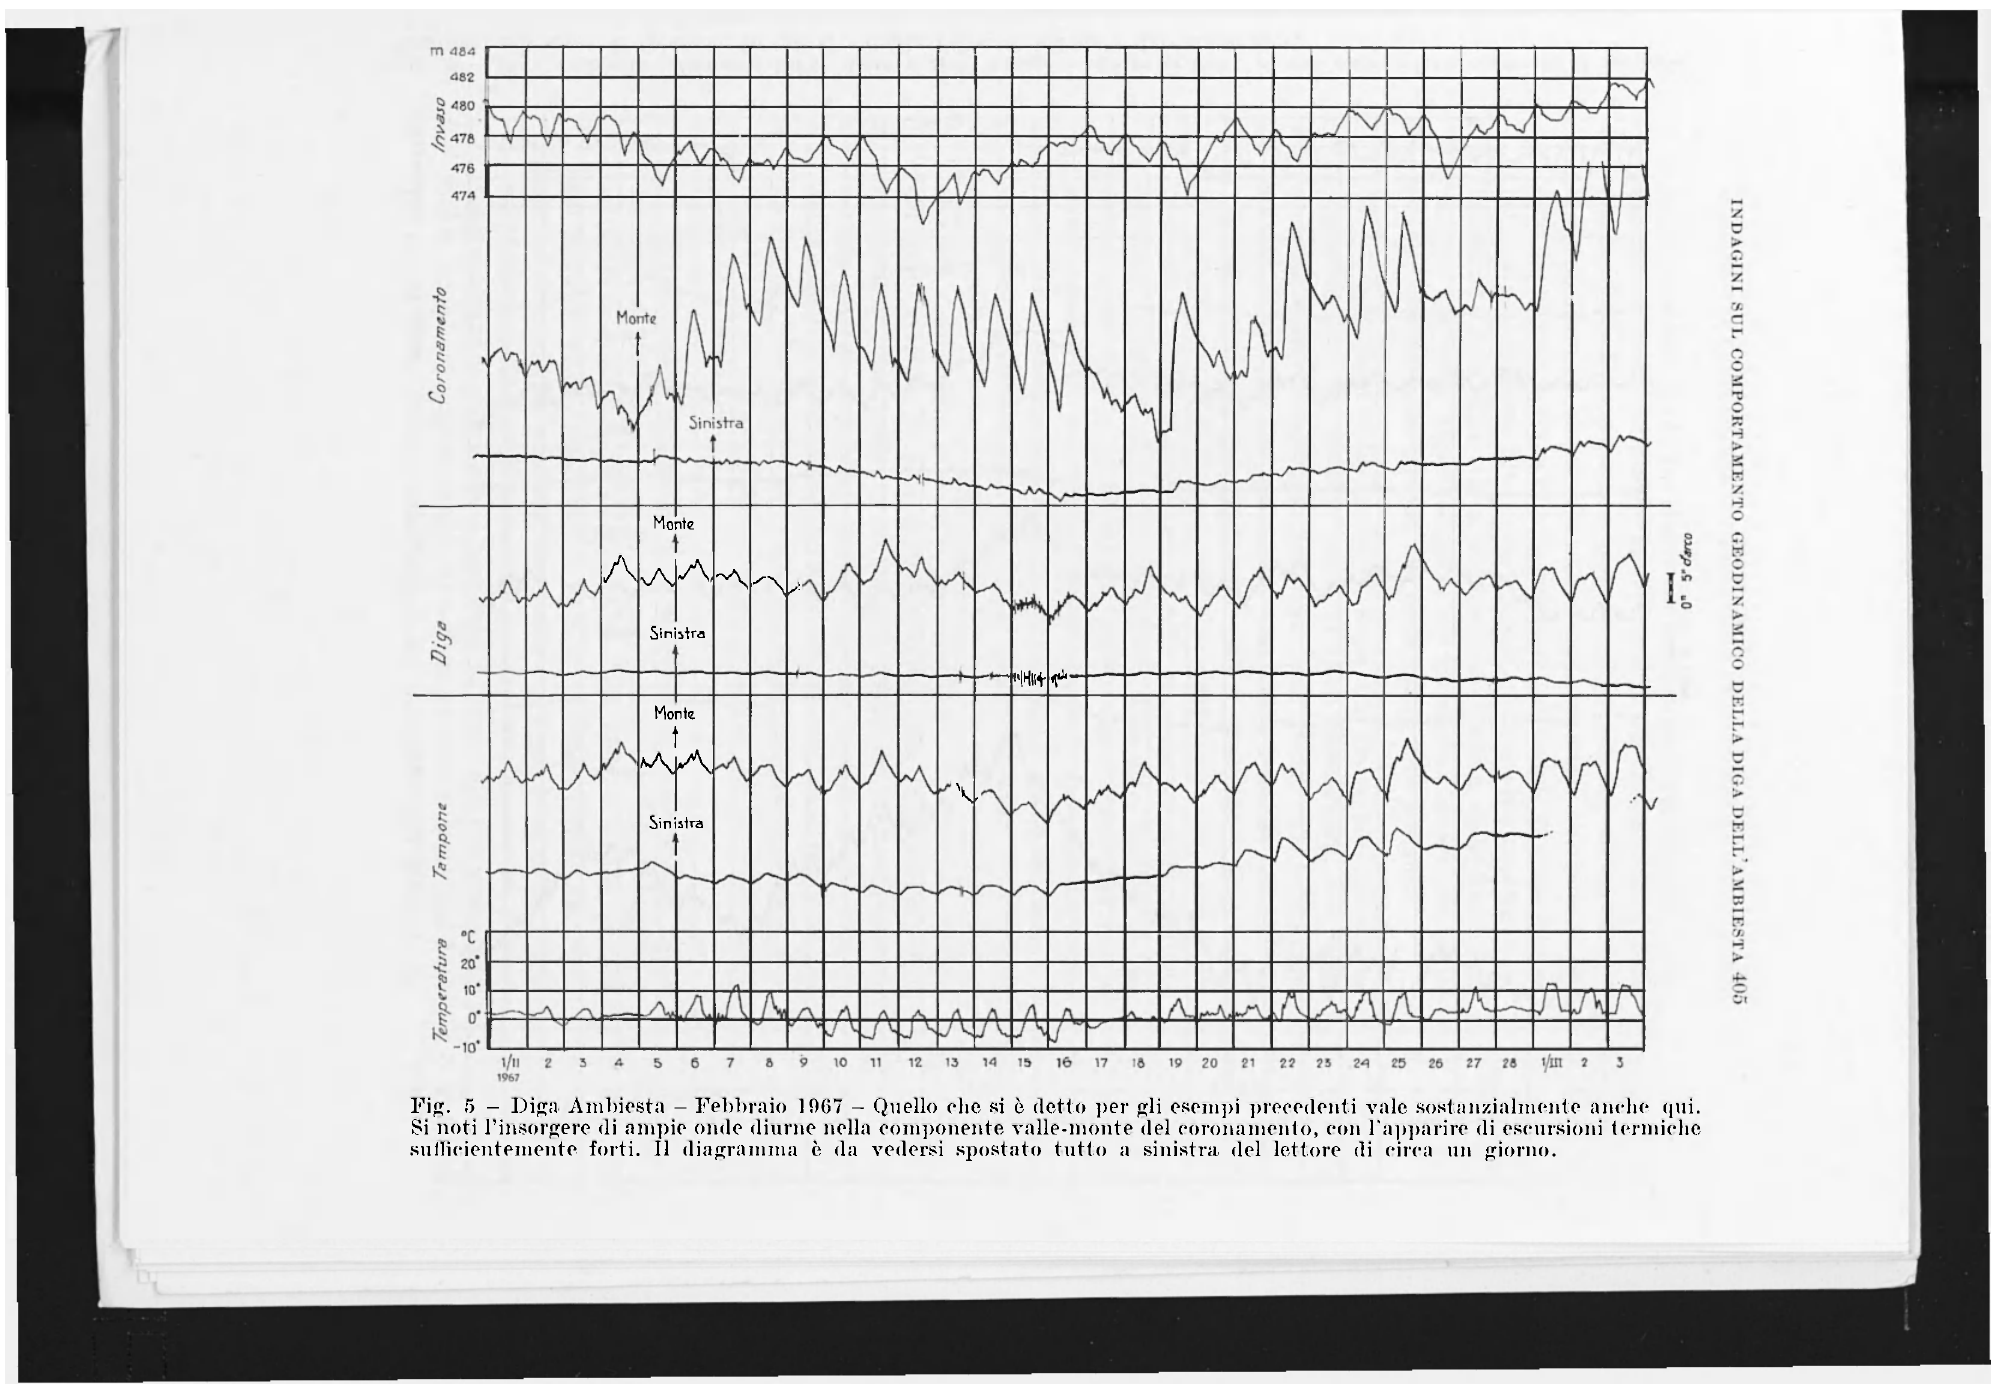
Fig. 5 - Diga Ambiesta - Febbraio 1967 - Quello che si è detto per gli esempi precedenti vale sostanzialmente anche qui. Si noti l'insorgere (li ampie onde diurne nella componente valle-monte del coronamento, con l'apparire di escursioni termiche sufficientemente forti. Il diagramma è da vedersi spostato tutto a sinistra del lettore di circa un